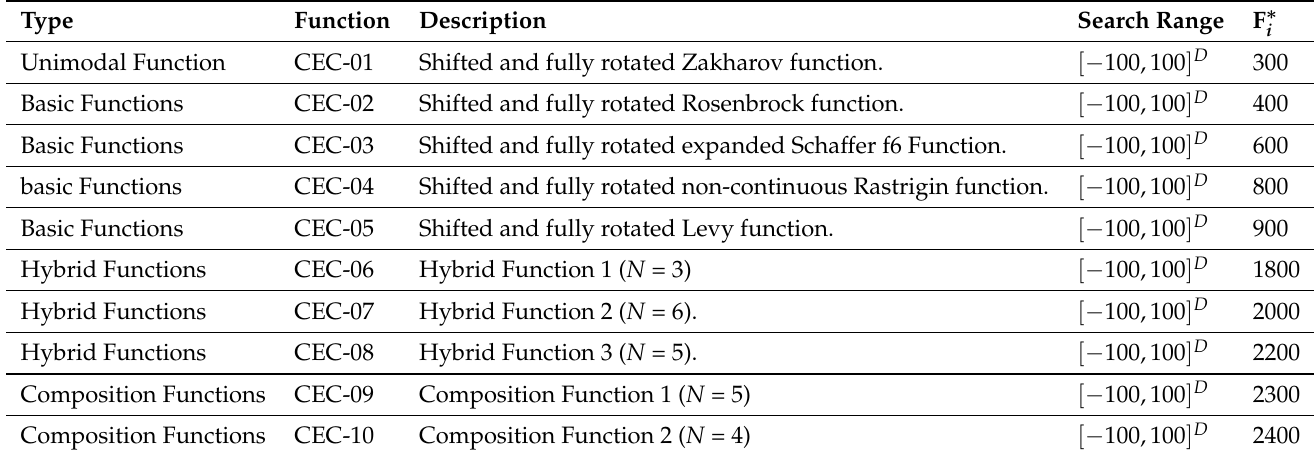
Table 5. The description of the CEC’22 test suite functions [61].